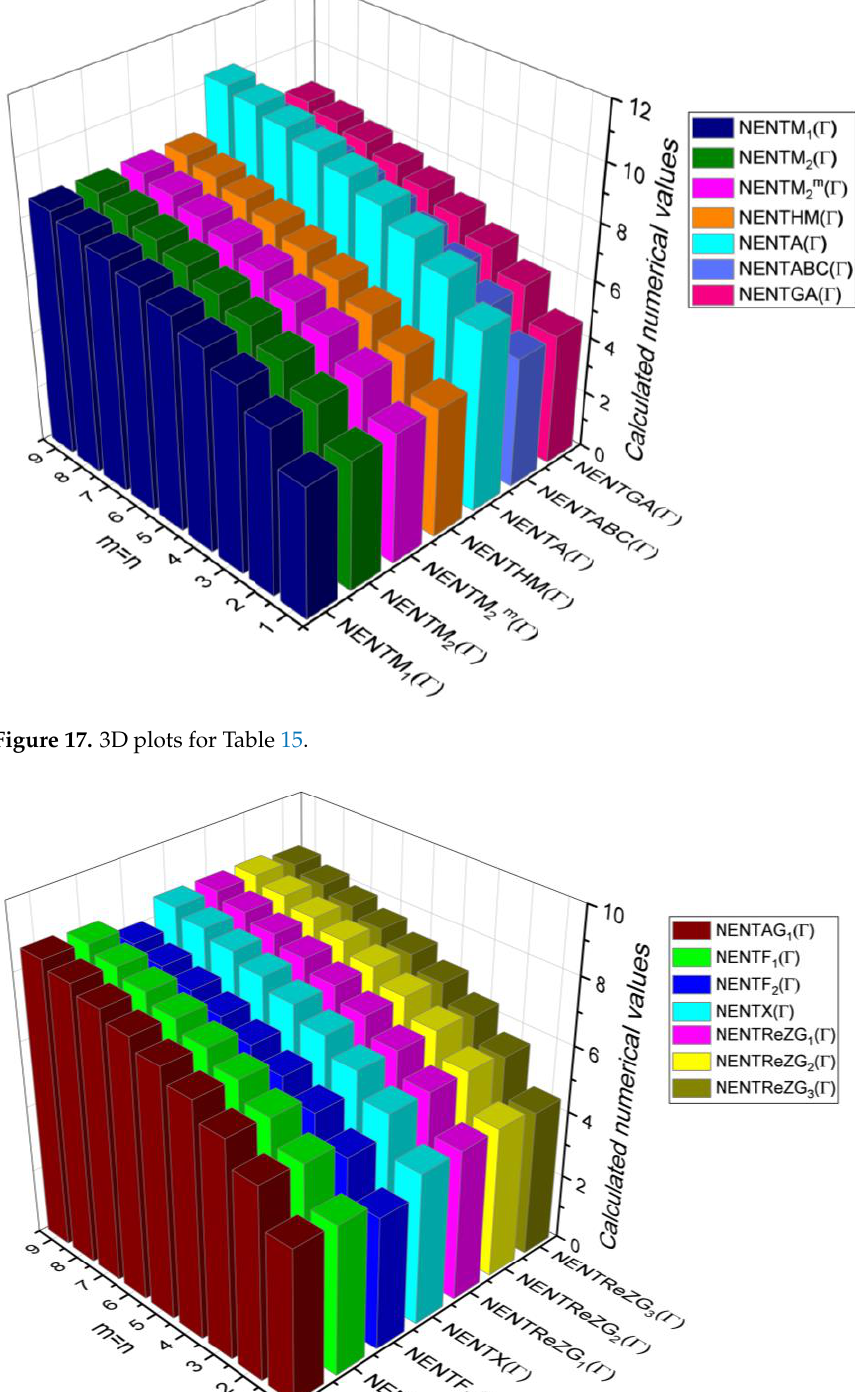
27 of 30 Table 14. Comparison Table for Theorem 8. 𝒎 = 𝒏